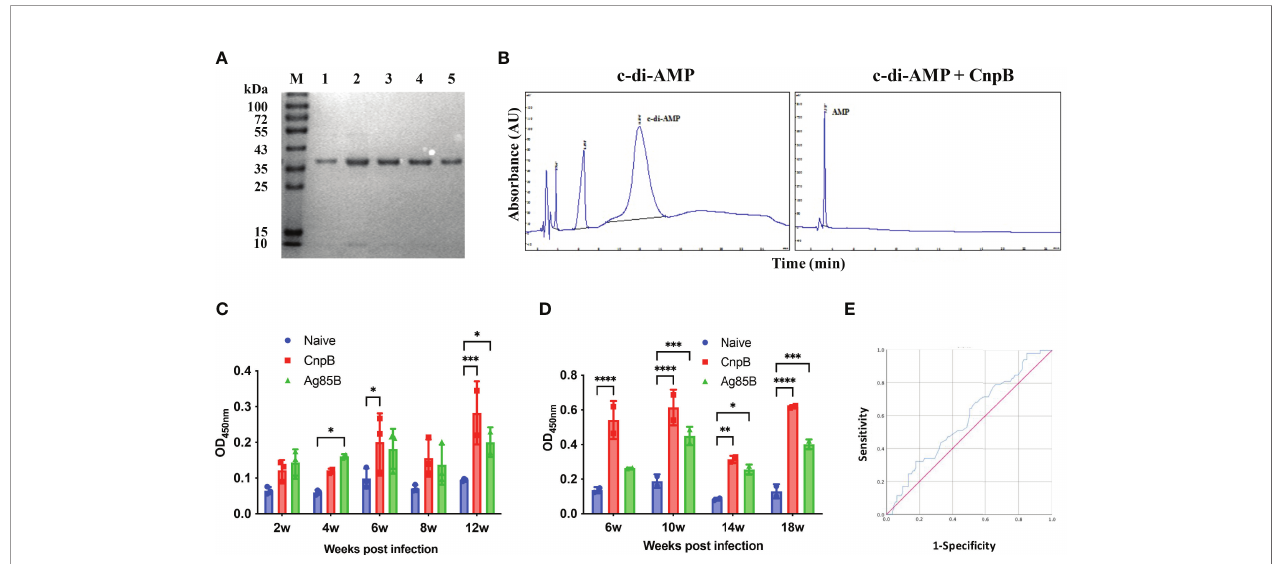
FIGURE 1 | Characterization of recombinant CnpB and detection of humoral immune response against CnpB. (A) CnpB was puri fi ed by Ni-NTA. Eluted proteins were analyzed using SDS-PAGE. Lane M, molecular marker. Lanes 1 to 5: eluted samples. (B) CnpB hydrolyzes c-di-AMP to AMP detected by HPLC. (C) After the mice were infected with M. tuberculosis , ELISA was used to detect the levels of anti-CnpB and anti-Ag85B antibodies in sera ( n =3). (D) After the guinea pigs were infected with M. tuberculosis , ELISA was used to detect the levels of anti-CnpB and anti-Ag85B antibodies in sera ( n =2). The results were shown as mean ± SD. (E) The receiver operating characteristic (ROC) curve of antibodies in sera from TB patients (blue curve). The X-axis represents the false positive rate, and the Y-axis represents the true positive rate. * P < 0.05, ** P < 0.01, *** P < 0.001, **** P <